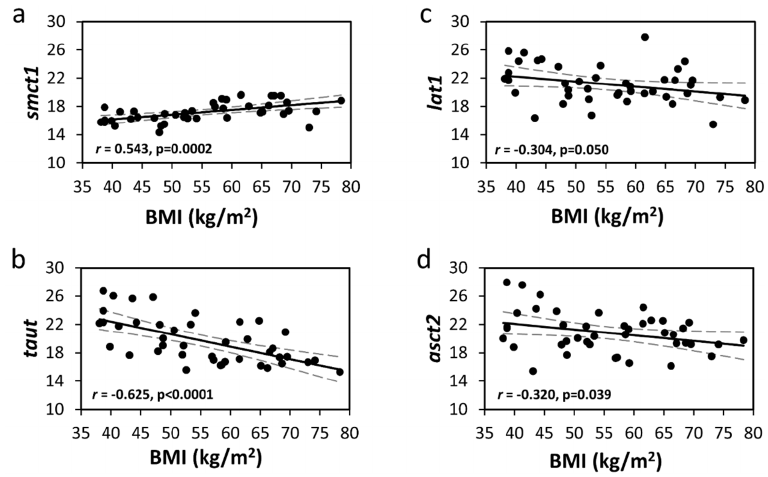
Figure 1 . Correlations between the mRNA abundance of the nutrient transporters (NTs) SMCT1 ( a ), TauT ( b ), LAT1 ( c ), and ASCT2 ( d ) with body mass index (BMI, kg/m 2 ) in 42 severely obese patients undergoing a Roux ‐ en ‐ Y Gastric Bypass. The jejunal mucosa was scraped and flash ‐ frozen in liquid nitrogen and stored at − 80 °C. RNA was extracted from the samples and quantitative real ‐ time–PCR performed for the NTs was studied. ( r = Pearson’s correlation coefficient, solid line is the best fit regression line, slashed line is the 95% confidence interval). The mRNA abundance for the NTs are expressed as 40 ‐Δ C T . Table 2. The jejunal mRNA abundances of the nutrient transporters (NTs) in 42 severely obese patients undergoing a Roux ‐ en ‐ Y Gastric Bypass stratified by body mass index (kg/m 2 ). The jejunal mucosa was scraped and immediately frozen in liquid nitrogen and stored at − 80 °C. RNA was extracted from the samples and quantitative real ‐ time–PCR was performed to determine the mRNA abundance of the NTs. The mRNA abundance for the NTs are expressed as 40 ‐Δ C T values. NT mRNA Abundance (40 ‐Δ C T Values) by BMI Quartile